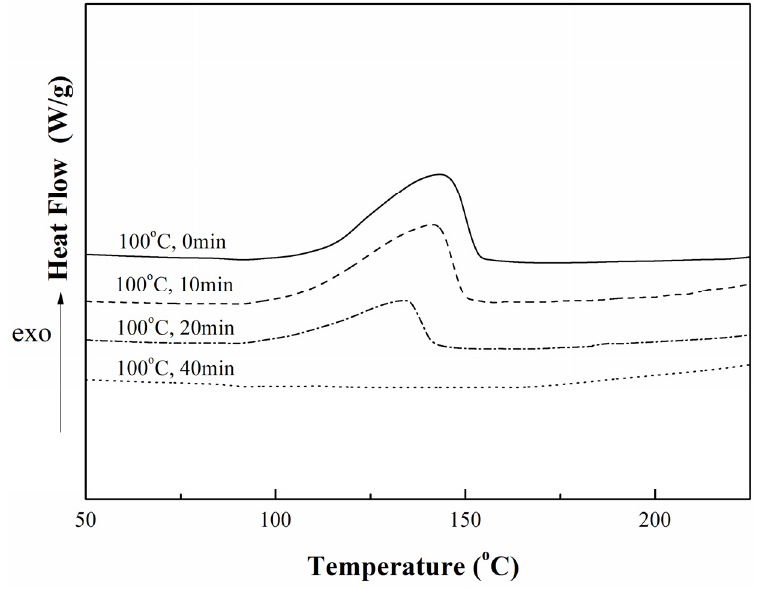
Figure 1. Differential Scanning Calorimetry (DSC) curves of 6%DFA-TGDDE systems at various reaction times, 10 °C/min.